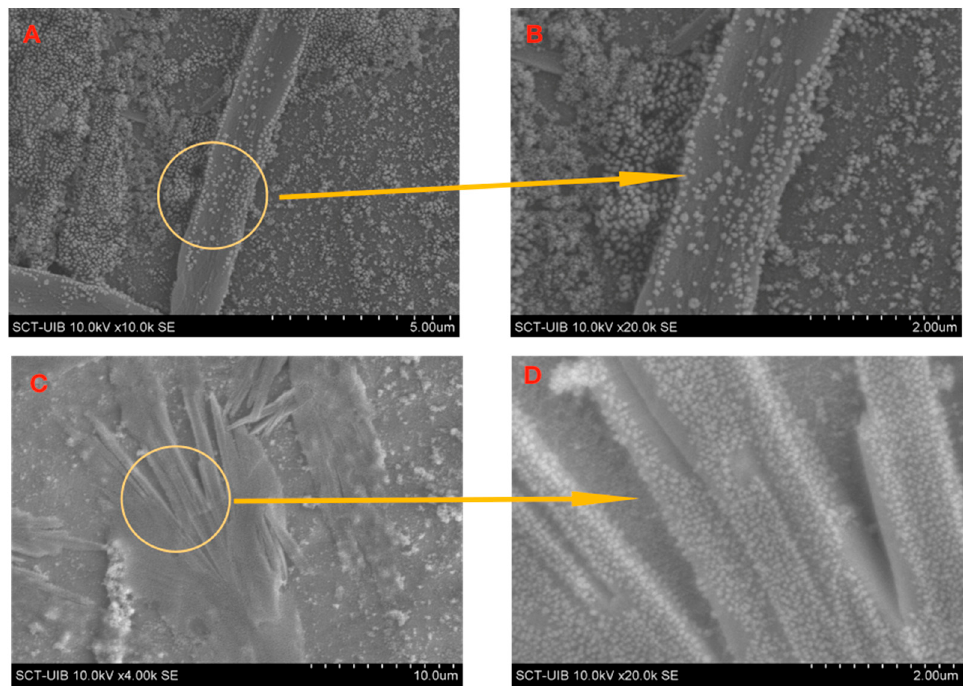
Figure 5. ( A , B ) SEM micrographs showing microfibres assembled between FeNP-BrPDI-DA and BKF. ( C , D ) FeNP-BrPDI-DA and BHA, in aqueous